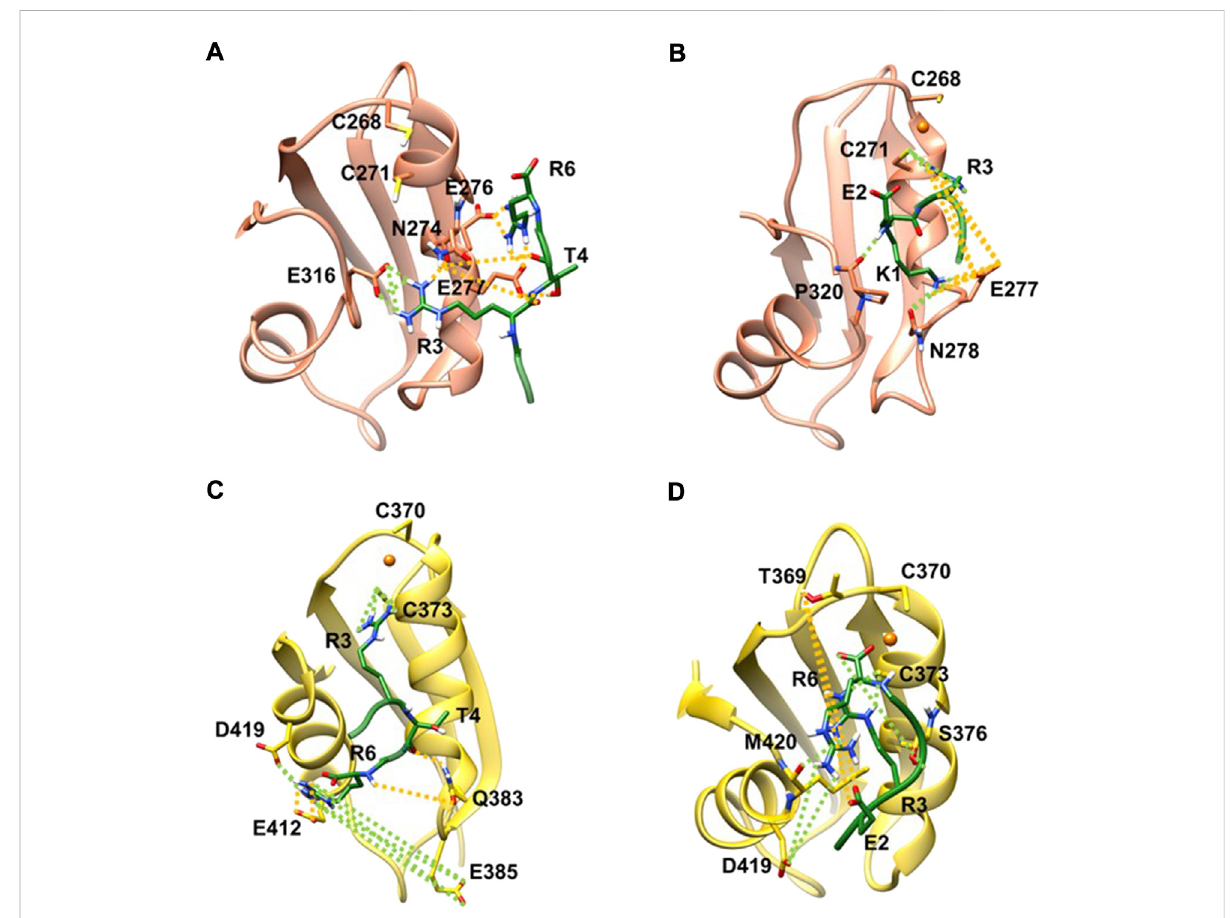
FIGURE 2 KER in complex with apo MBD3 (A) , (orange new cartoon), holo MBD3 (B) (yellow new cartoon), and holo MBD4 (C, D) (yellow new cartoon). Hydrogen-bonds are denoted as dotted linesinthe samecolor scheme as inSupplementaryTable S2. Oxygen atomsaredenotedinred,nitrogen in blue, sulphur in yellow, polar hydrogen atoms in white, copper in orange, and carbon atoms in the color scheme of the protein. Nonpolar hydrogen atoms are omitted for